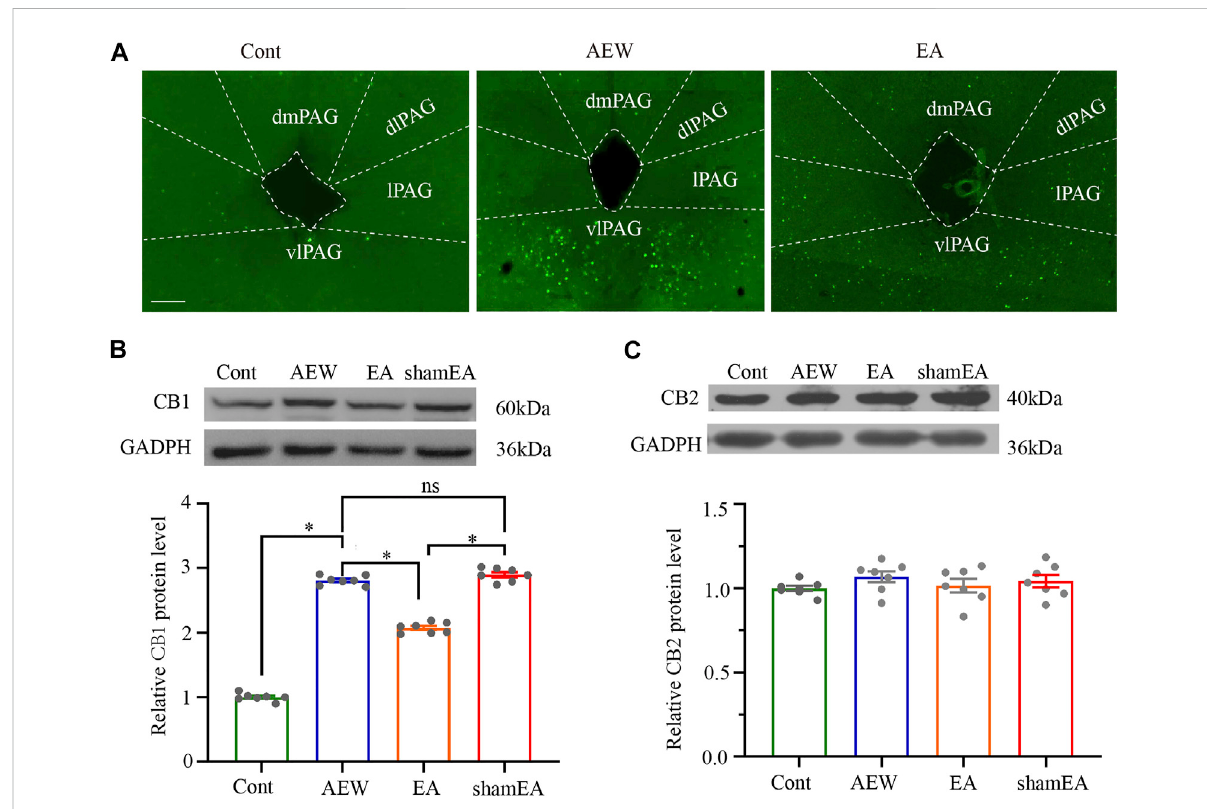
FIGURE 2 EffectofEAontheexpressionofCB1andCB2receptorproteinlevelsinthevlPAG. (A) Theexpressionofc-Fosinthecontrolgroup,AEWandEA group. (B) Representativegelimage(upper)andquanti fi cation(bottom)oftheproteinlevelofCB1receptorsincontrol,AEW,EAandshamEAgroups. (C) Representative gel image (upper) and quanti fi cation (bottom) of the protein level of CB2 receptors in control, AEW, EA and sham EA groups. GAPDH (36 kDa) was used as a loading control. The protein band at 60 kDa corresponds to the CB1 receptors protein. The protein band at 40 kDa corresponds to the CB2 receptors protein. Data are expressed as means ± SEM ( n = 6 mice in each group). * p <